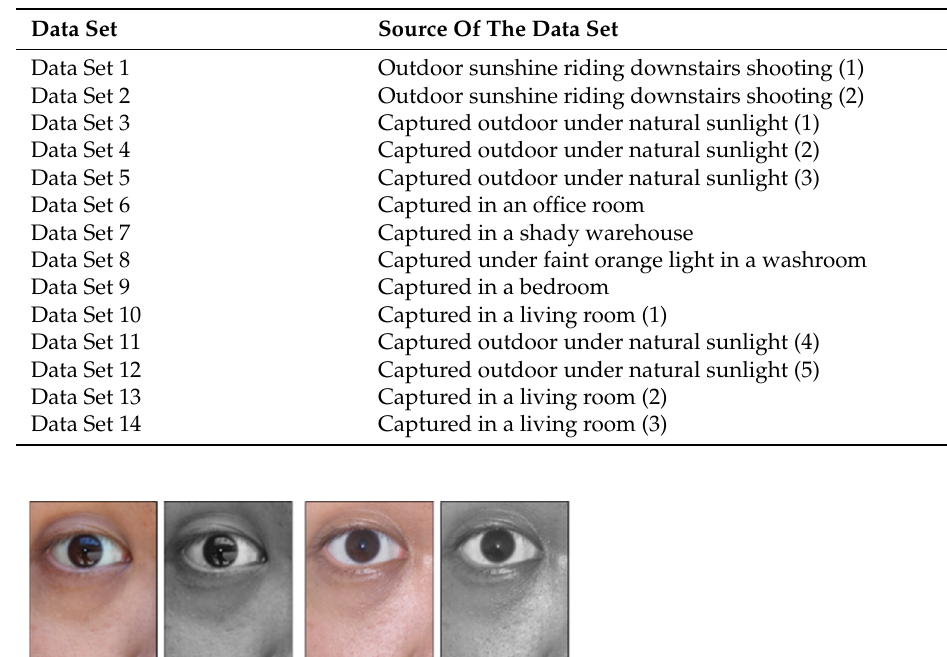
Table 4. Sources of each experimental data set.